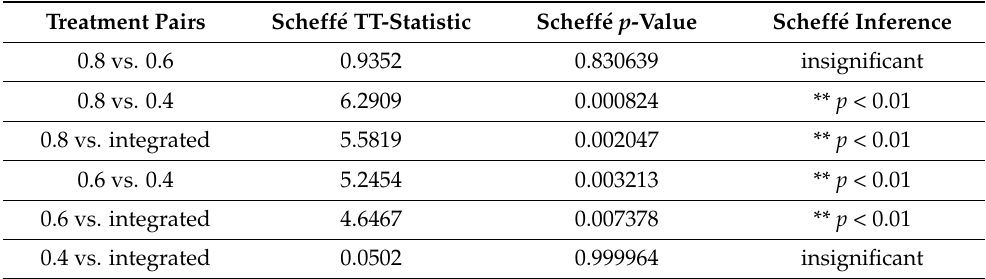
Table 9. Scheff é multiple comparison analysis results from ammonia datasets. Treatment